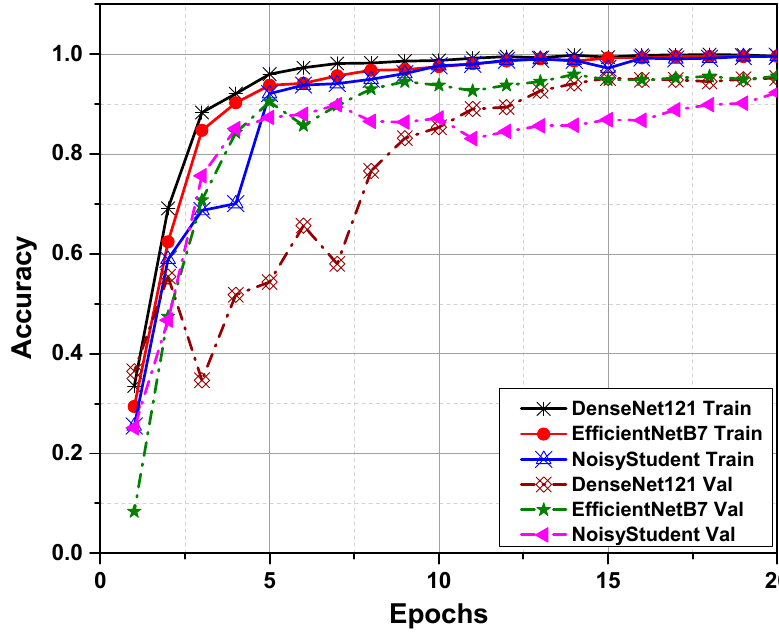
Figure 24. Accuracy vs. Epochs plot for our model. Table 1. Accuracy of the pre-trained and proposed model at various split ratios.